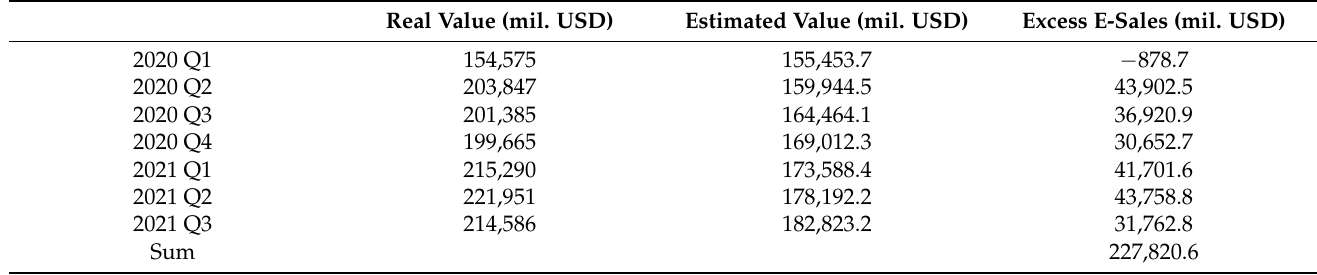
Table 3. Excess e-commerce retail sales over the pandemic window (in millions of dollars). Real Value (mil. USD)